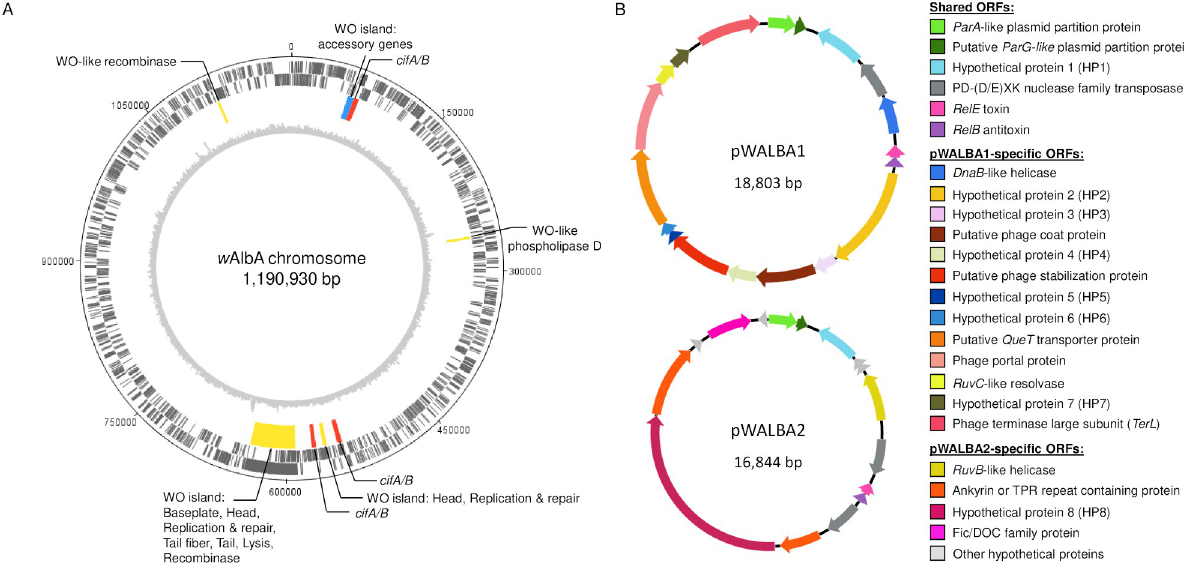
Fig 1. Genome map of the w AlbA chromosome and plasmids. (A) w AlbA chromosome. Two outer circles: protein-coding genes on forward and reverse strands (black). Third circle: WO prophage regions (yellow: phage core genes, red & blue: phage eukaryotic modules). Inner grey circle: Illumina sequencing depth per 2,000 bp window from a non-WGA mosquito sample (see methods). (B) w AlbA plasmids and predicted coding sequences.